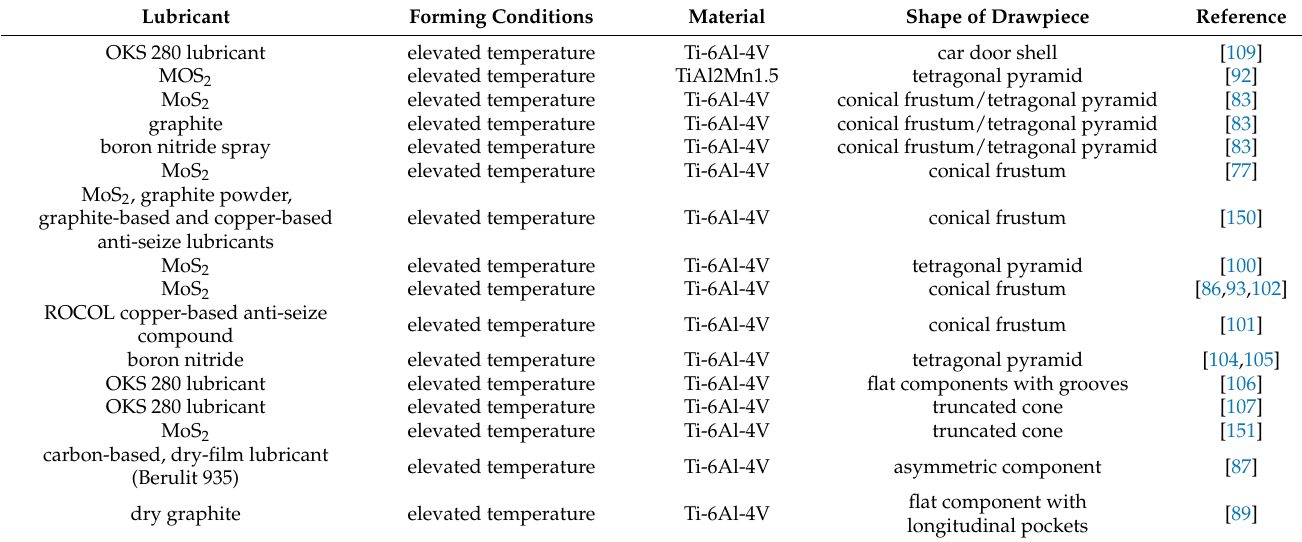
Table 1. Typical lubricants used in SPIF of selected